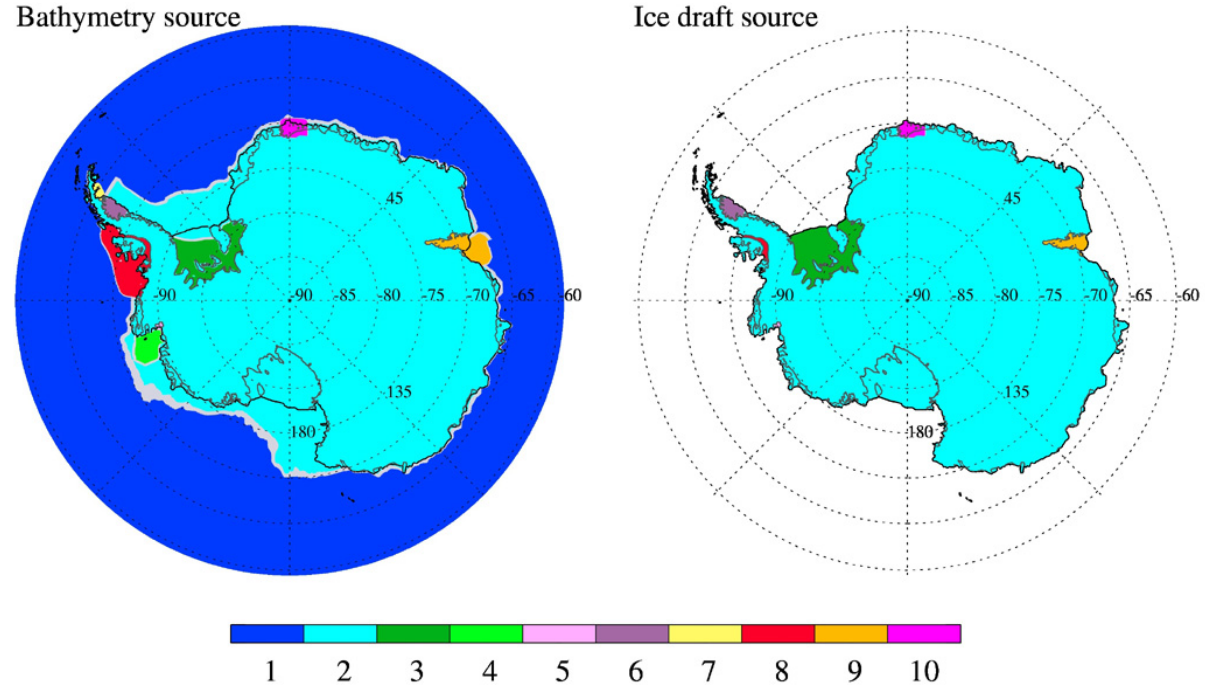
Figure 3. Data sources for ocean bathymetry (left) and ice sheet / shelf topography (right). See Table 1 for an explanation of numbers. Grey areas mark transition zones between the data